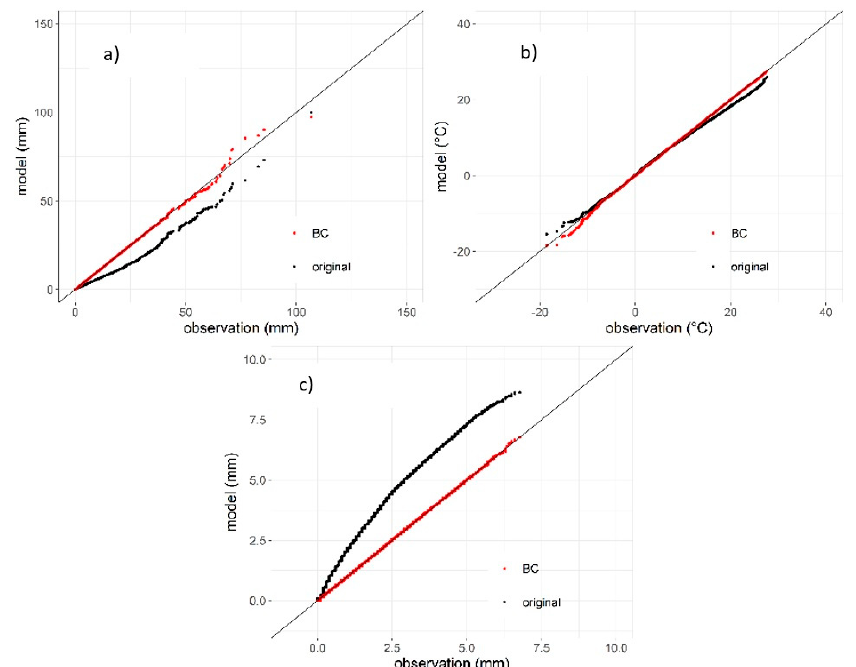
Figure 2. Quantile-quantile (Q-Q) plots of observations against model data for the precipitation ( a ), air temperature ( b ), and evapotranspiration ( c ) data during the reference period, 1981–2010, for the grid cell which contains a Ljubljana-Bežigrad meteorological station. Red dots represent bias-corrected (BC) data, black dots represent raw model data. BC values adjust better to observations than raw model data. It should be noted that we did not apply BC on station values, but on interpolated values in the model grid.